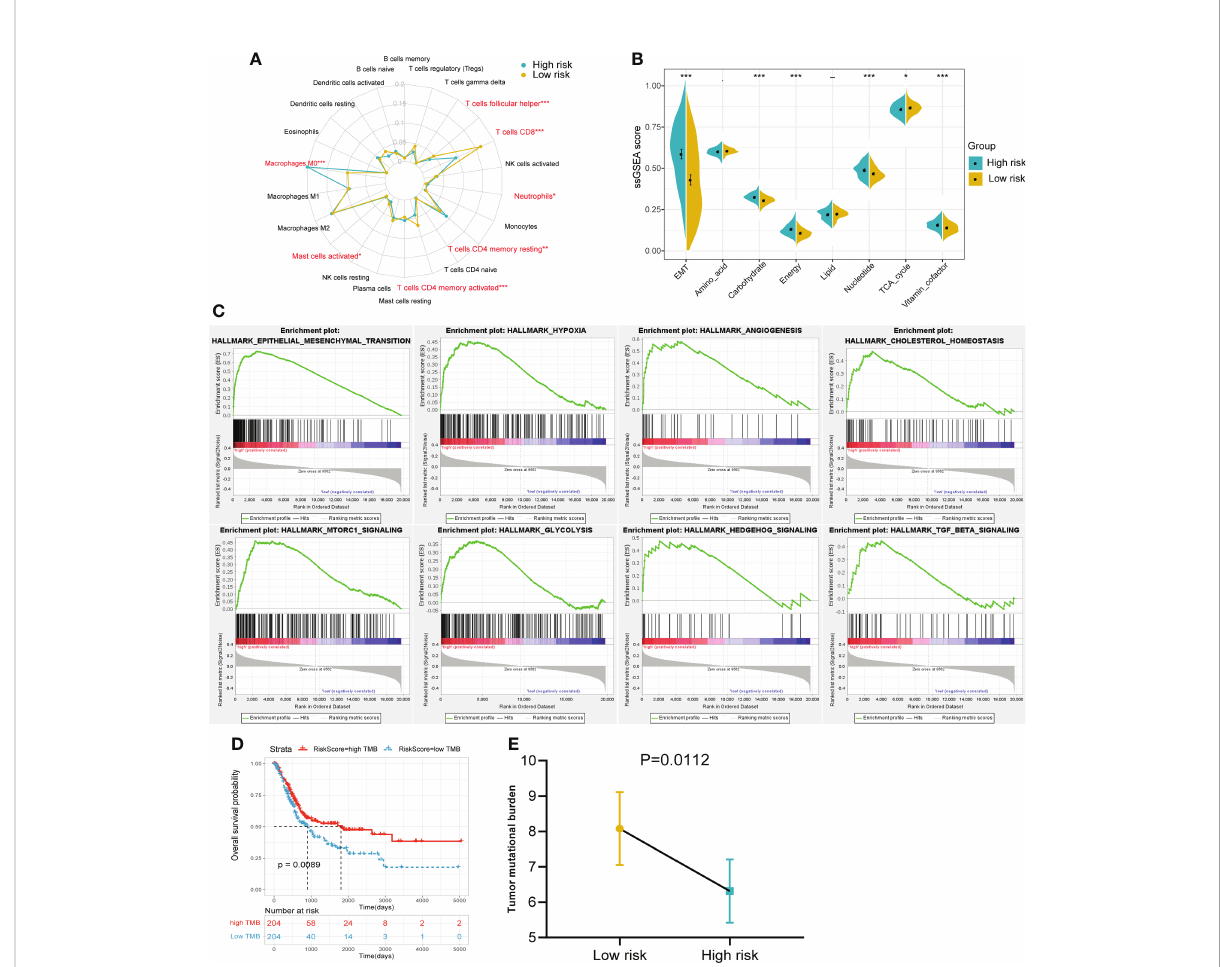
FIGURE 6 The immune in fi ltration, metabolic status and pathway enrichment between high and low risk groups in TCGA cohort. (A) Comparison of 22 types of immune cell in fi ltration. (B) Comparison of various metabolic scores of ssGSEA result. (C) Multiple malignant regulatory pathways were signi fi cantly enriched in the high risk group. (D) The KM survival curve of OS between high and low TMB groups. (E) Comparison of the TMB value between risk groups. *p<0.05,